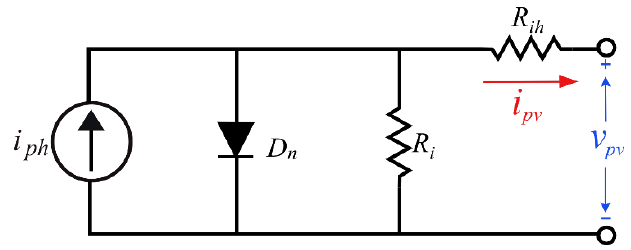
Figure 3. The equivalent circuit for a PV cell.